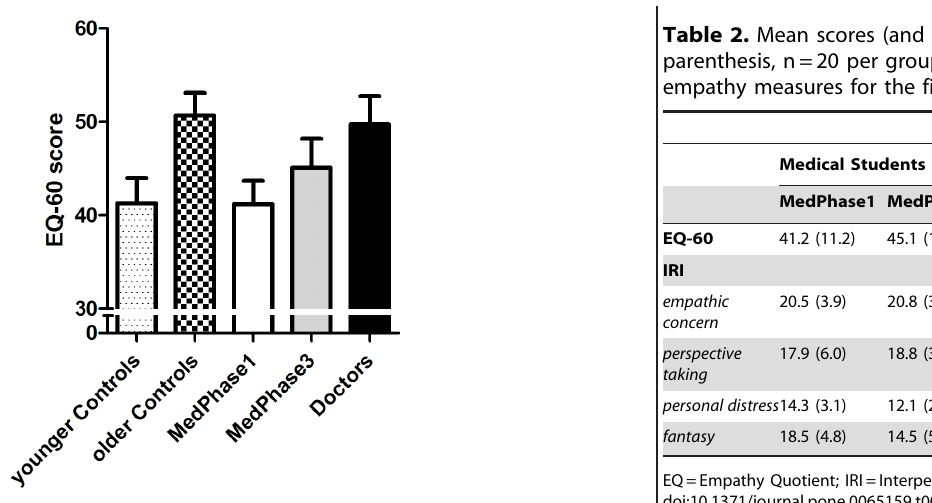
Figure 1. Mean scores for the Empathy Quotient questionnaire (EQ-60) for the five participant groups. Error bars represent the